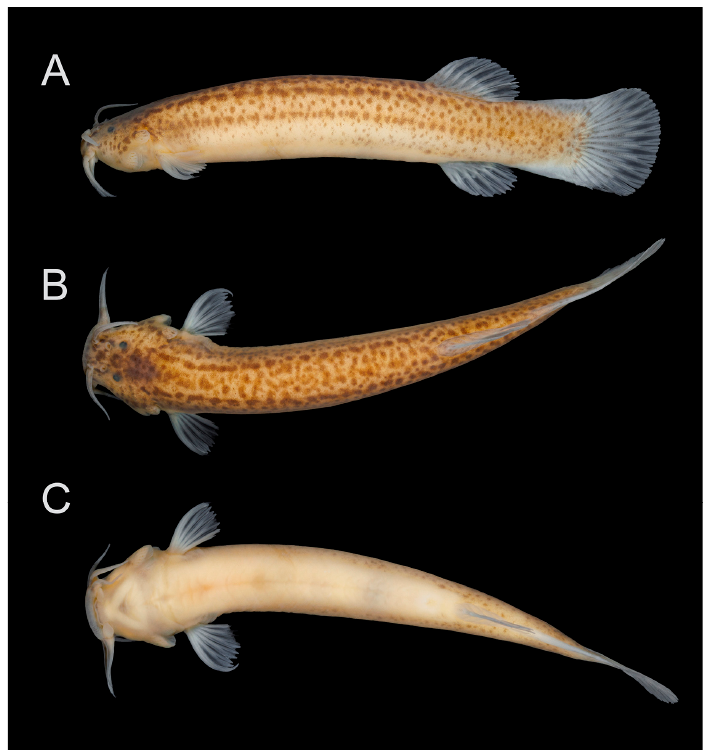
Figure 2. Trichomycterus candidus , UFRJ 12824, Conceição da Aparecida Municipality, 43.1 mm SL: ( A ) lateral, ( B ) dorsal, and ( C ) ventral views. Diagnosis. Trichomycterus candidus di ff ers from all other congeners of Cryptocambeva , except for Trichomycterus listruroides Costa, Ka tz & Azevedo-Santos sp. nov. and Trichomycterus uberabensis Costa, Azevedo-Santos & Ka tz sp. nov., by the pelvic fi n and girdle that are absent in most specimens, or rudimentary in two specimens (UFRJ 12728, see discussion below), in contrast to being always well developed. Trichomycterus candidus di ff ers from T. listruroides Costa, Ka tz & Azevedo-Santos sp. nov. and T. uberabensis Costa, Azevedo-Santos & Ka tz sp. nov. by having a unique colour pa tt ern, comprising minute dark brown dots, which are equal to or smaller than the orbital diameter, irregularly arranged over the fl ank, and separated by broad interspaces; a horizontal row of slightly larger dark brown dots along the longitudinal midline of the fl ank; and another similar horizontal row on the dorsal portion of the fl ank (vs. fl ank dots always larger than the orbital diameter, forming a vermiculate pa tt ern in T. listruroides , and small round spots in T. uberabensis ). Trichomycterus candidus is also distinguished from T. listruroides Costa, Ka tz & Azevedo-Santos sp. nov. by having a caudal fi n margin not aligned with the caudal peduncle (vs. in a continuous line); fewer dorsal (19 or 20 vs. 24 or 25) and ventral (17 or 18 vs. 20) procurrent caudal- fi n rays; fewer vertebrae (38 or 39 vs. 40); dorsal- fi n origin at the vertical between the centrum of the 22nd or 23rd vertebra (vs. 24th); and anal- fi n origin